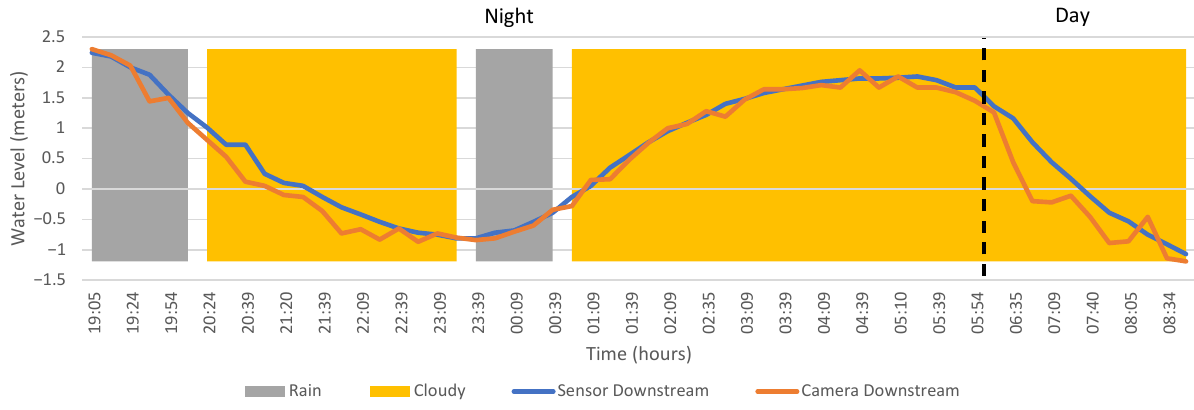
Figure 10. Water level with reference to MSL; scenario 2 displays some variance in weather